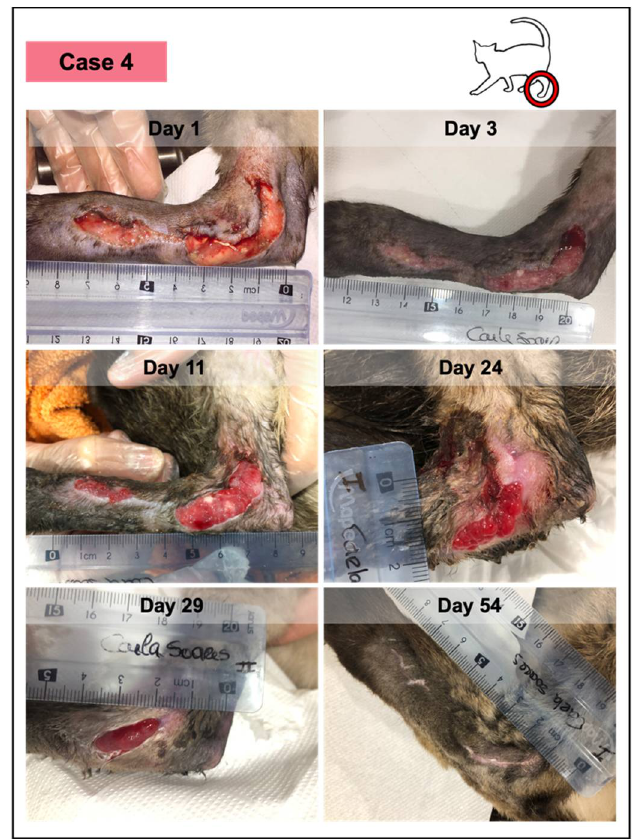
Figure 6. Wound healing evolution of case 4. This animal presented an extensive traumatic laceration, anemia, positivity for immunodeficiency virus, and Bartonella sp. According to the owner, the lesion had 48–50 h and presented a yellow purulent exudate. Medical debridement was performed under sedation (day 1), revealing a fibrinous wound bedding. Throughout the study, the patient received PRFs from different canine donors, but at different time points, considering that PRFs grafted at each timepoint were from the same donor. No adverse events were documented in any of them. The last figure (at day 54) represents the lesioned area, 12 days after the reported closure, which occurred on day 42, with complete epithelization and scar, and evident skin contraction.